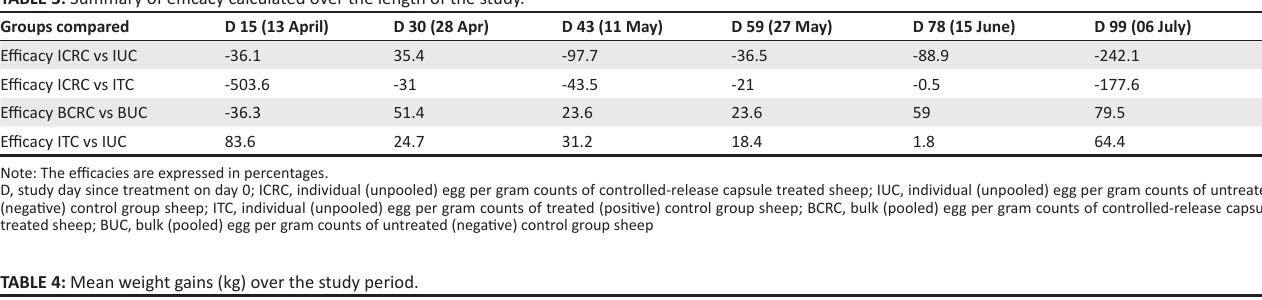
TABLE 3: Summary of efficacy calculated over the length of the study. Groups compared Efficacy ICRC vs IUC